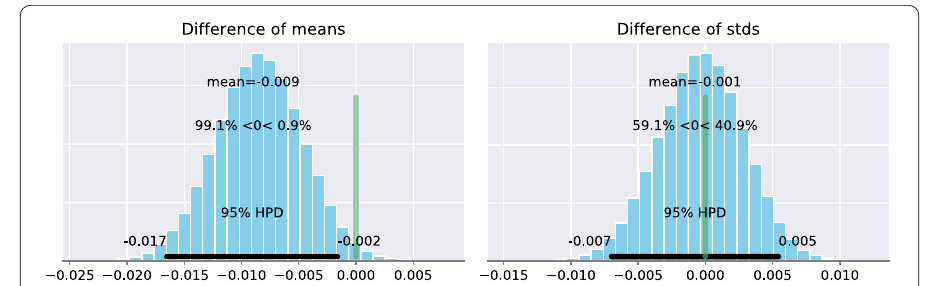
Figure 29 Posterior distributions and 95% credible intervals of differences for the normalized-by-mean “c3__lag_1” feature. Left is the difference of group means, and right is the difference of group standard